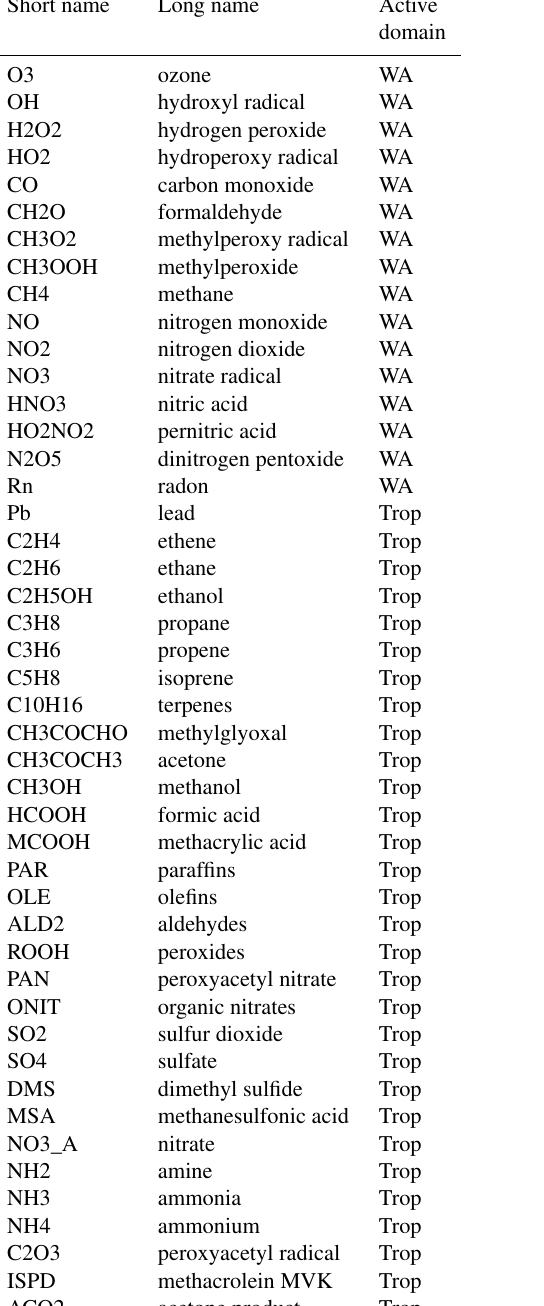
Table A1. Trace gases in C-IFS-TS, along with their chemically active domain: troposphere (Trop), stratosphere (Strat) or whole at- mosphere